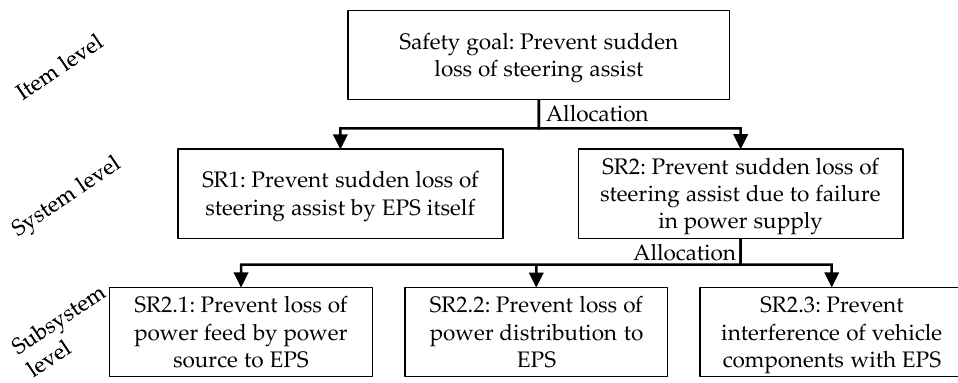
Figure 1. Hierarchical safety requirements derivation for the safety goal